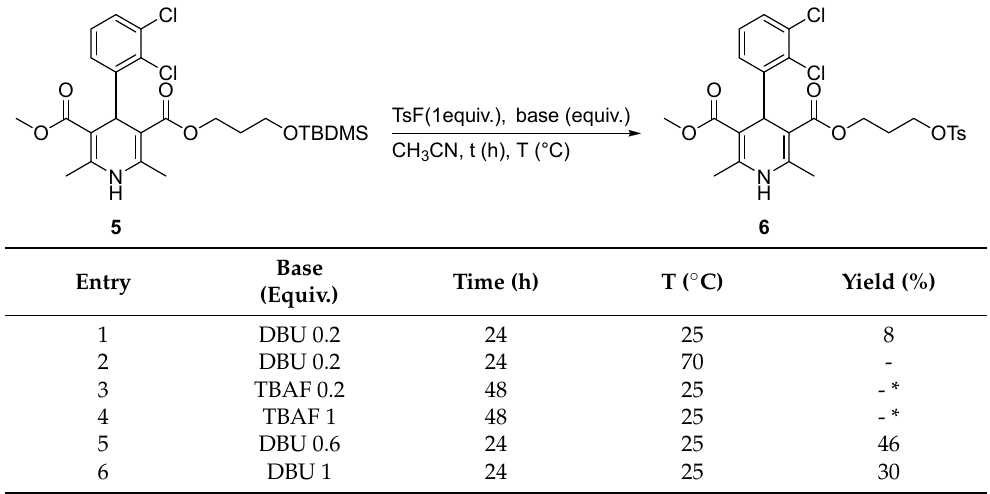
Table 1. Optimization